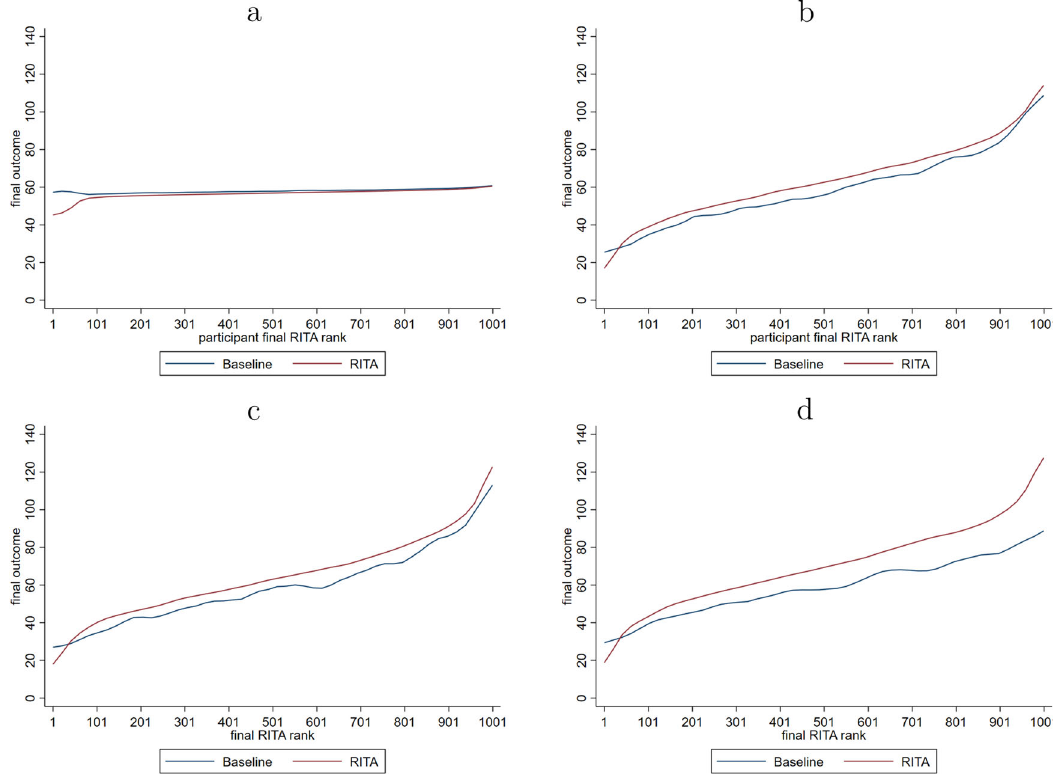
Fig. 5 Individual cumulative outcomes. a Results for World 1. b Results for World 2. c Results for World 3. d Results for World